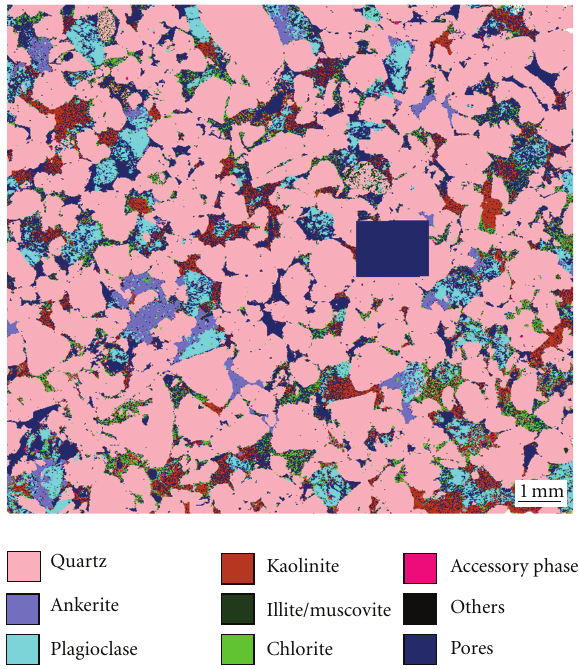
Figure 3: QEMSCAN image from the lower-permeability zone. (The solid blue rectangle is a file conversion